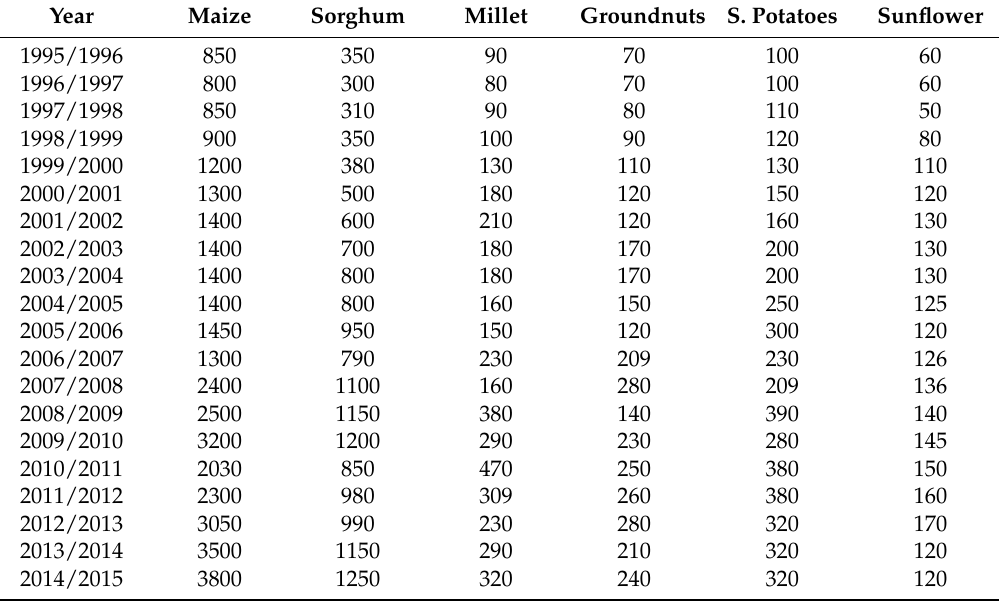
Table 7. Estimated Abandoned Land (ha) Due to Unproductivity in Kongwa District. Year Maize Sorghum Millet Groundnuts S. Potatoes